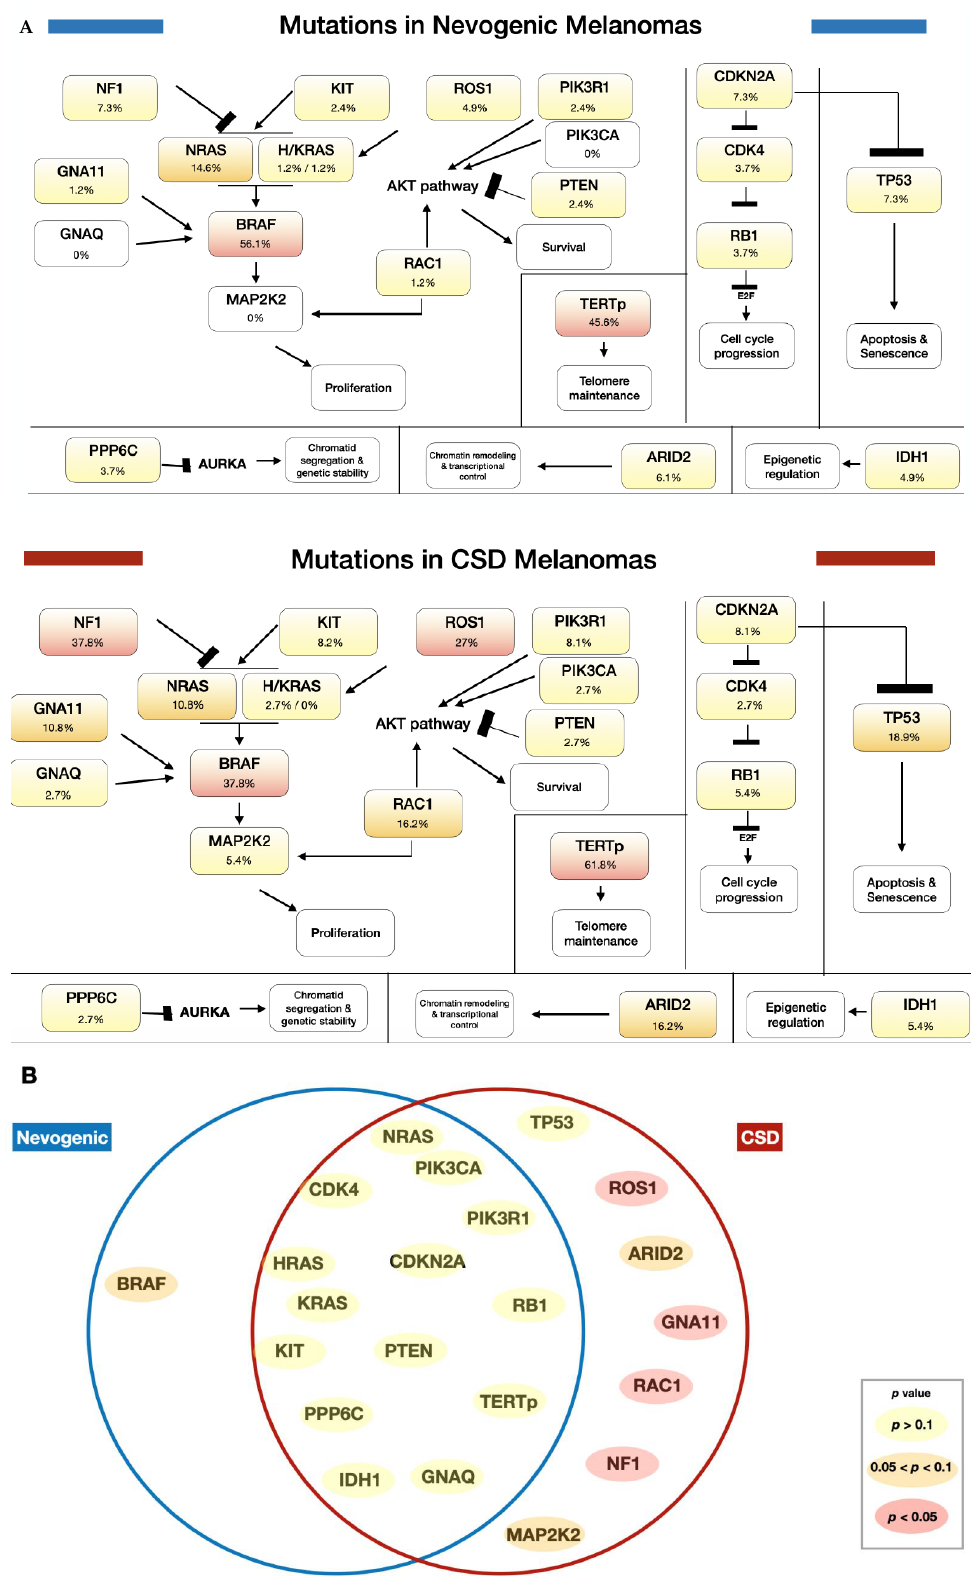
Figure 1. Mutational prevalence and mutational association for etiopathogenic pathways. Mutational distribution between nevogenic and CSD melanomas. Frequency of mutations in the different genes for the nevogenic and CSD groups ( A ); Graphical representation of the association of mutations in the different genes with either group based on their p -value ( B ). The mean comparison showed a statistically significant difference in the total num- ber of pathogenic mutations between the nevogenic and CSD melanomas (1.9 vs. 3.4; p = 0.029), but no differences were found in the number of UV-induced mutations. The distribution of the molecular subtypes among the described major etiopatho- genic groups was the following: the “ BRAF+ ” subtype was significantly associated with the nevogenic melanomas (39/75, 52.0% vs. 9/31, 29.0%), while “ NF1+ ” was related to the CSD melanomas (1/37, 1.3% vs. 9/31, 29.0%) ( p < 0.001) (Table 3). 2.2. Mechanistic analysis of Pathways The mechanistic analysis based on the mutational profiles to predict the effect on normal skin showed that 67 circuits were significantly dysregulated in the nevogenic mel- anomas (66 upregulated; 1 downregulated), and 122 circuits were dysregulated in the CSD melanomas (109 upregulated; 13 downregulated). Fifty-one circuits were statistically significantly higher in the CSD than in nevogenic melanomas (Figure S5). A radar plot was visualized with the altered pathways in the context of the annotated hallmarks of cancer (Figure 2). The plot showed that the mutational profiles from the CSD melanomas had a higher number of dysregulated circuits (counts; “Cs”) annotated to hallmarks of cancer than those from the nevogenic melanomas, especially when considering prolifera- tive signaling (26 vs 50 Cs), replicative immortality (14 vs. 20 Cs), resisting cell death (16 vs. 28 Cs), and genome instability and mutation (11 vs. 15 Cs). The enrichment analysis based on simulated circuit activity data from normal skin showed that dysregulations in proliferative signaling and replicative immortality were statistically significant in the nevogenic ( p = 0.01; p = 0.002) and CSD ( p = 0.0004; p = 0.0002) melanomas compared to their corresponding normal skin (Figure S6).